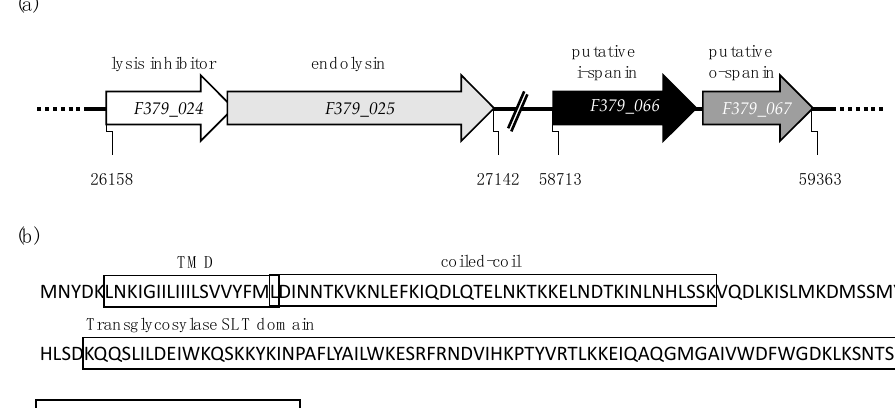
Figure 2. Illustration of lytic genes predicted in Firehammervirus phage F379. ( a ) Relative positions of predicted lytic genes in the genome of phage F379. ( b ) Secondary structure of phage F379 endolysin. The endolysin contains an N-terminal transmembrane domain linked to the catalytic soluble transglycosylase (SLT) domain by a sequence containing a coiled-coil motif. No known lysis mechanism has been described for an endolysin with this topology.